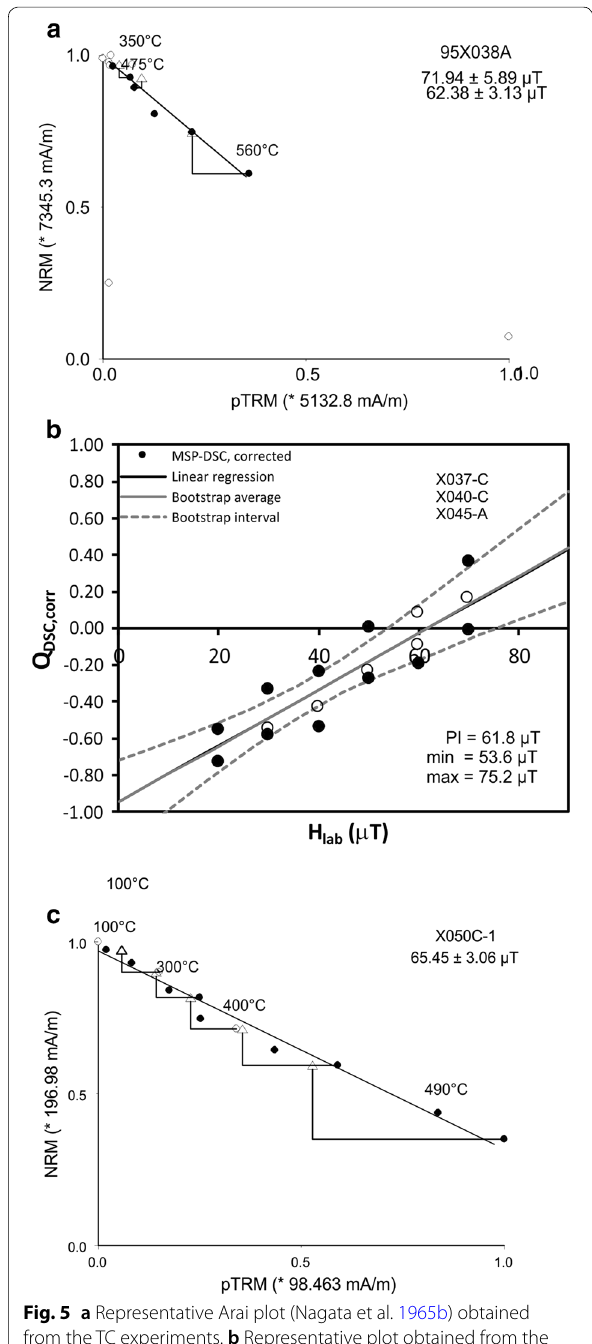
Fig. 5 a Representative Arai plot (Nagata et al. 1965b) obtained from the TC experiments. b Representative plot obtained from